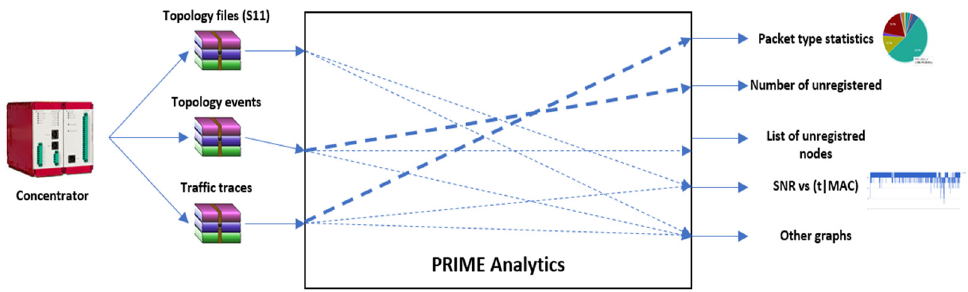
Figure 7. Overview of the inputs and outputs of PRIME Analytics.